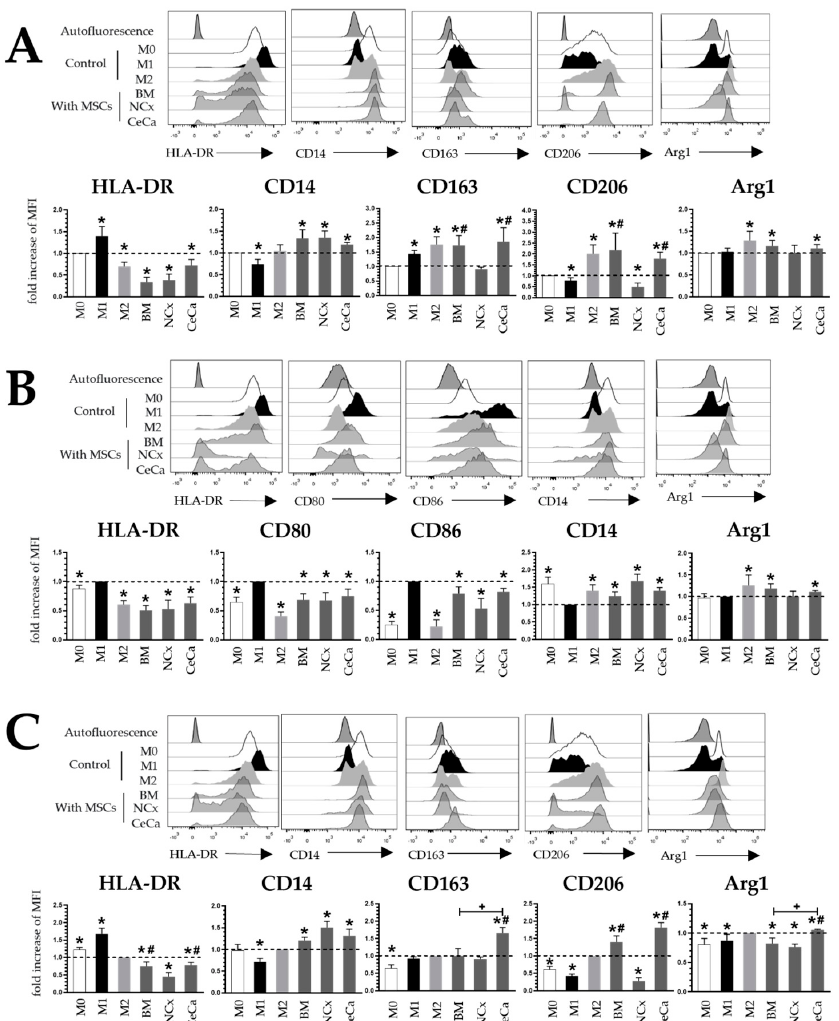
Figure 1. Coculture with CeCa-MSCs increases the expression of M2 membrane markers and decreases M1 markers in macrophages. ( A ) Representative histograms and bar graphs of the mean fold increase with respect to the M0 control for M1 and M2 markers in macrophages cocultured with MSCs in the absence of inducer medium. ( B ) Representative histograms and bar graphs of the mean fold increase with respect to the M1 control for M1 and M2 markers in macrophages cocultured with MSCs in the presence of M1 inducer medium. ( C ) Representative histograms and bar graphs of the mean fold increase with respect to the M2 control for M1 and M2 markers in macrophages cocultured with MSCs in the presence of M2 inducer medium. Bar graphs represent the mean with standard deviation. * Significant difference with respect to control, # significant difference with respect to NCx-MSCs, + significant difference with respect to BM-MSCs ( p < 0.05); n = 6; dotted line indicates the control for the comparison of fold increase. M0, absence of inducer medium; M1, inducer medium for M1 polarization; M2, inducer medium for M2 polarization.